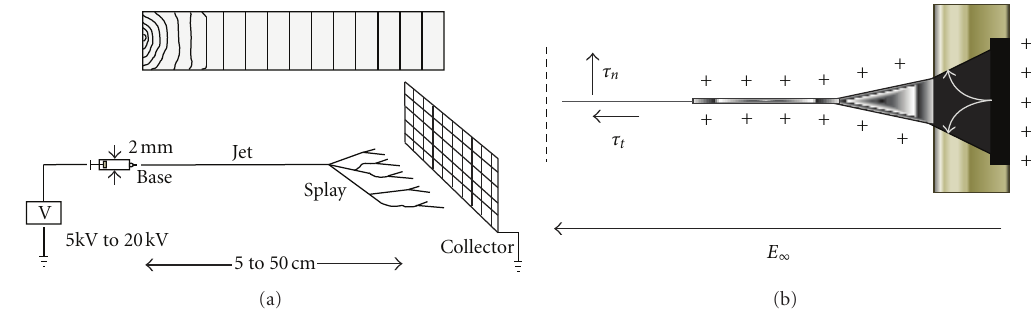
Figure 1: (a) Electrospinning system. (b) Taylor’s